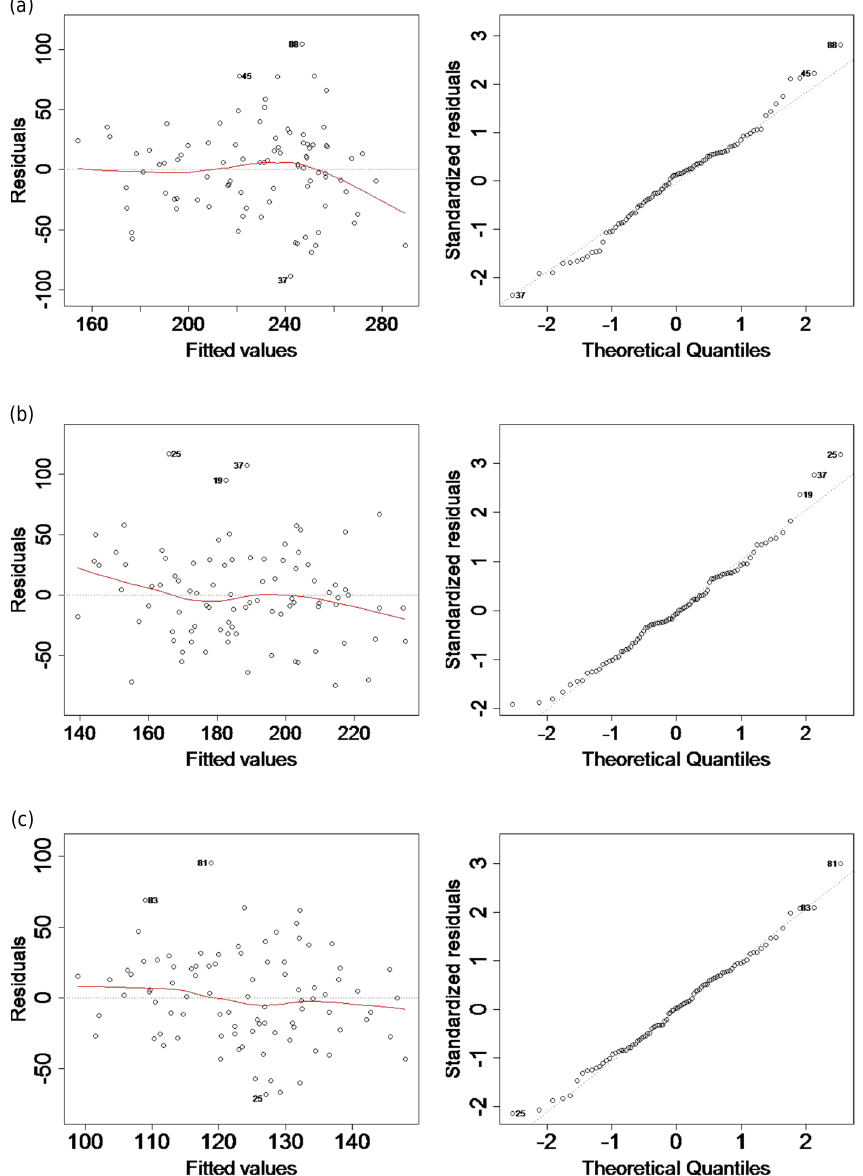
Figure 4. Residuals × fitted values and theoretical quantiles, for the summer. (a) AMZ, (b) NEB, and (c) LPB.